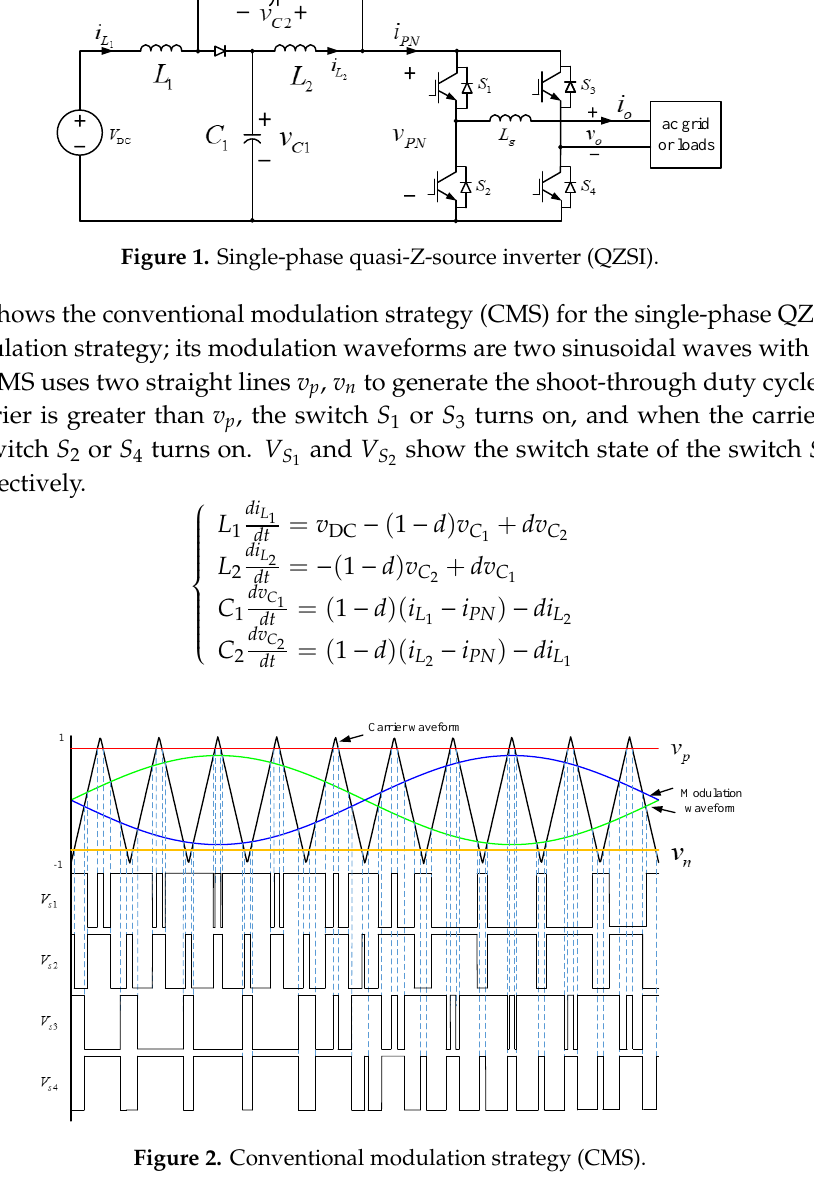
Figure 2. Conventional modulation strategy